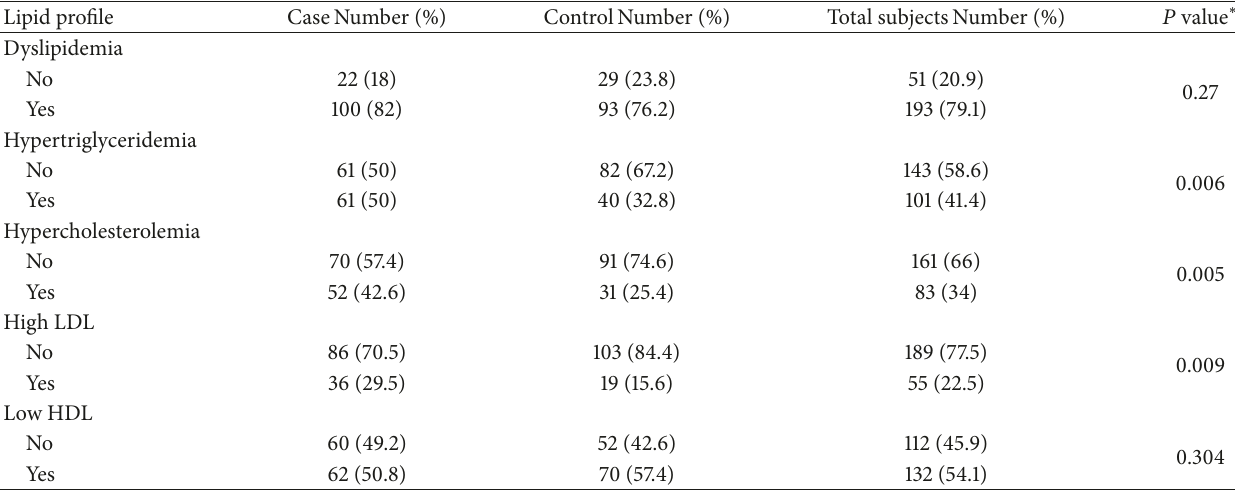
Table 2: Lipid profile of participants in case and control groups.